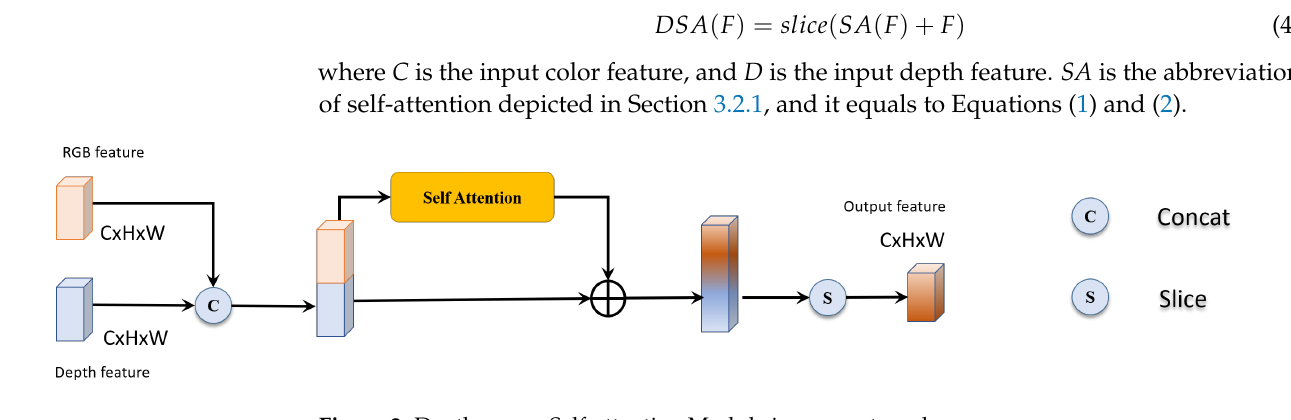
Figure 2. Depth-aware Self-attention Module in a concat